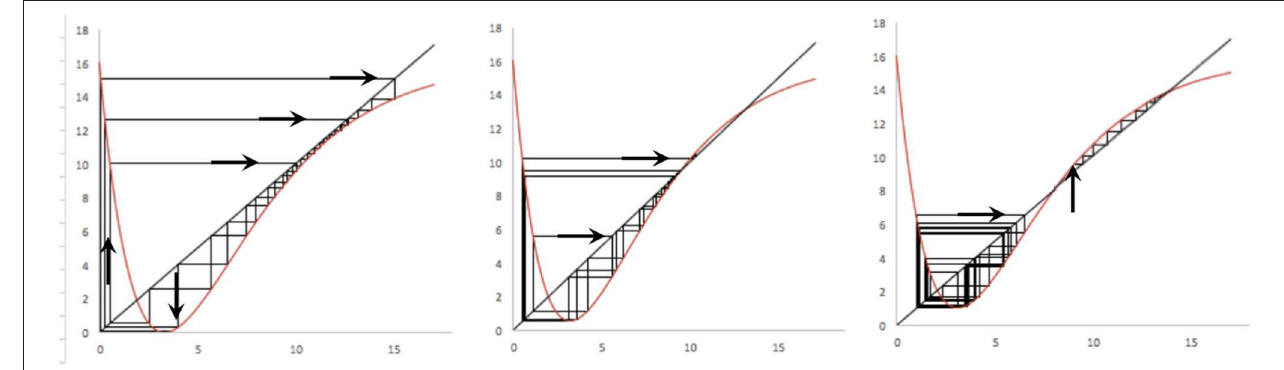
0.3). (Middle) = 0.31). (Right) Alternative equilibria, in which the =